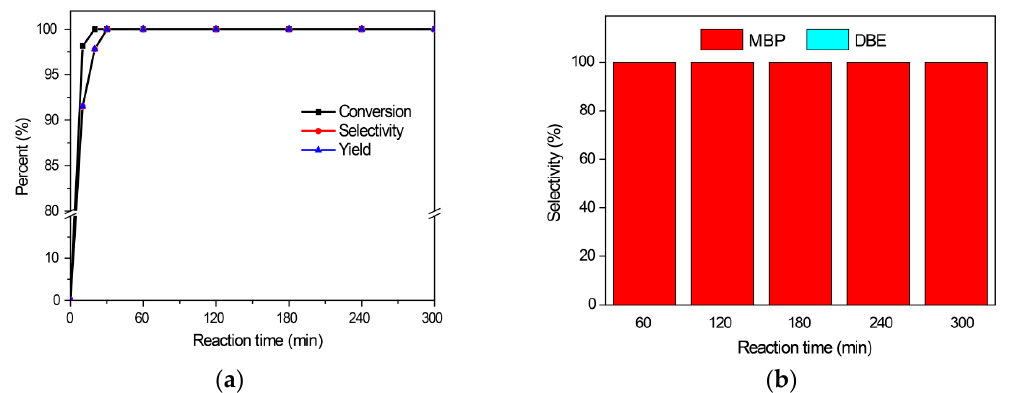
Figure 5. Benzylation reaction of benzene and benzyl alcohol at 353 K. ( a ) Conversion (based on benzyl alcohol), selectivity and yield (referred to diphenylmethane). ( b ) Product distribution of monobenzylation products (MBP, diphenylmethane in this case) and dibenzyl ether (DBE).